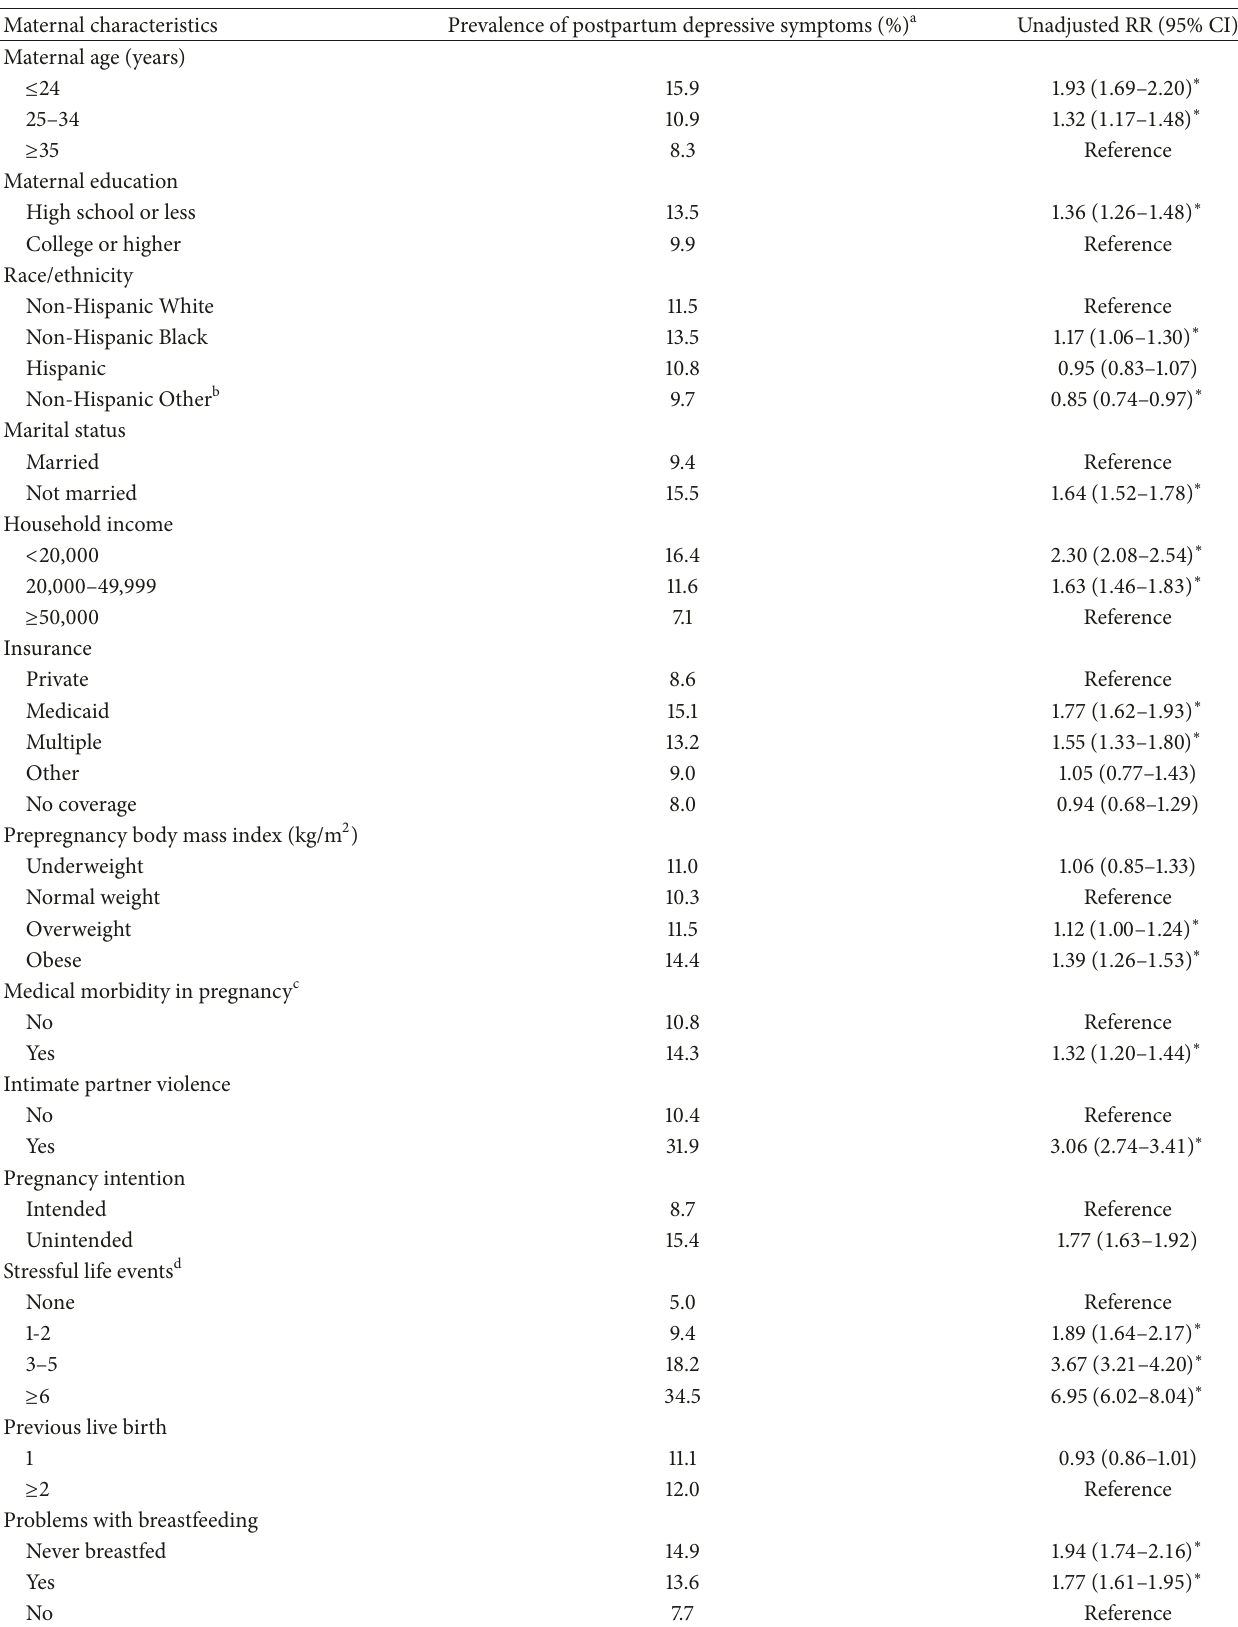
Table 2: Factors associated with postpartum depressive symptoms, Pregnancy Risk Assessment Monitoring System,